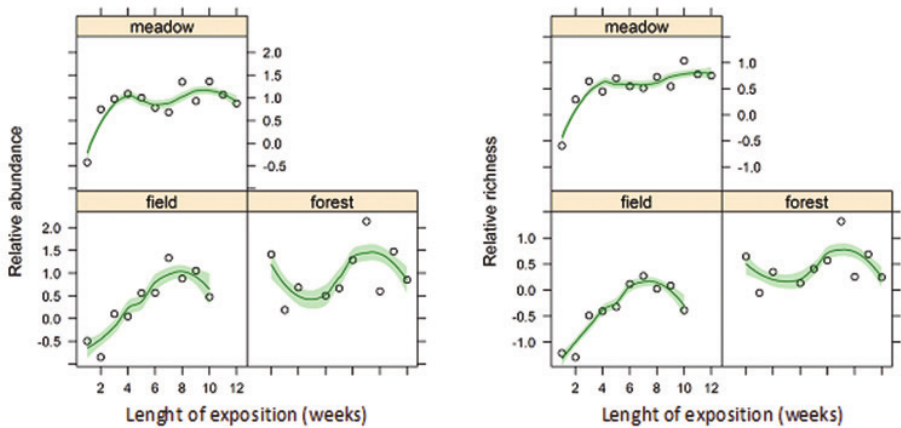
Figure 2. Changes in myriapod communities inside hay-bait traps installed in three biotopes during the 12 week trapping period. Qualitative as well as quantitative parameters are shown for these communities. Open dots are observed parameters, whereas solid lines represent models of succession including standard errors (green